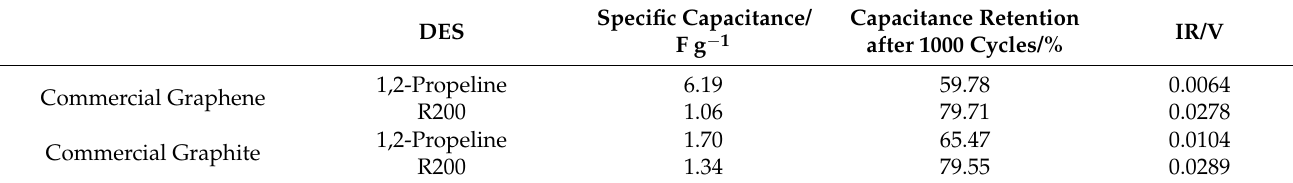
Table 4. Electrochemical parameters for both graphene and graphite in 1,2-propeline and R200 eutectic mixtures at 30 ◦